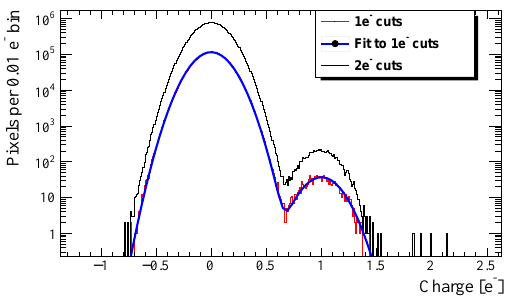
Figure 16: Spectrum of measured pixel charge in SENSEI, after the event selection cuts for the 1e − and 2e − analyses. A double-Gaussian fit is shown for the 1e − selec- tion. There were no 3e − or 4e − events. Figure from Ref. [ 74 ] 6